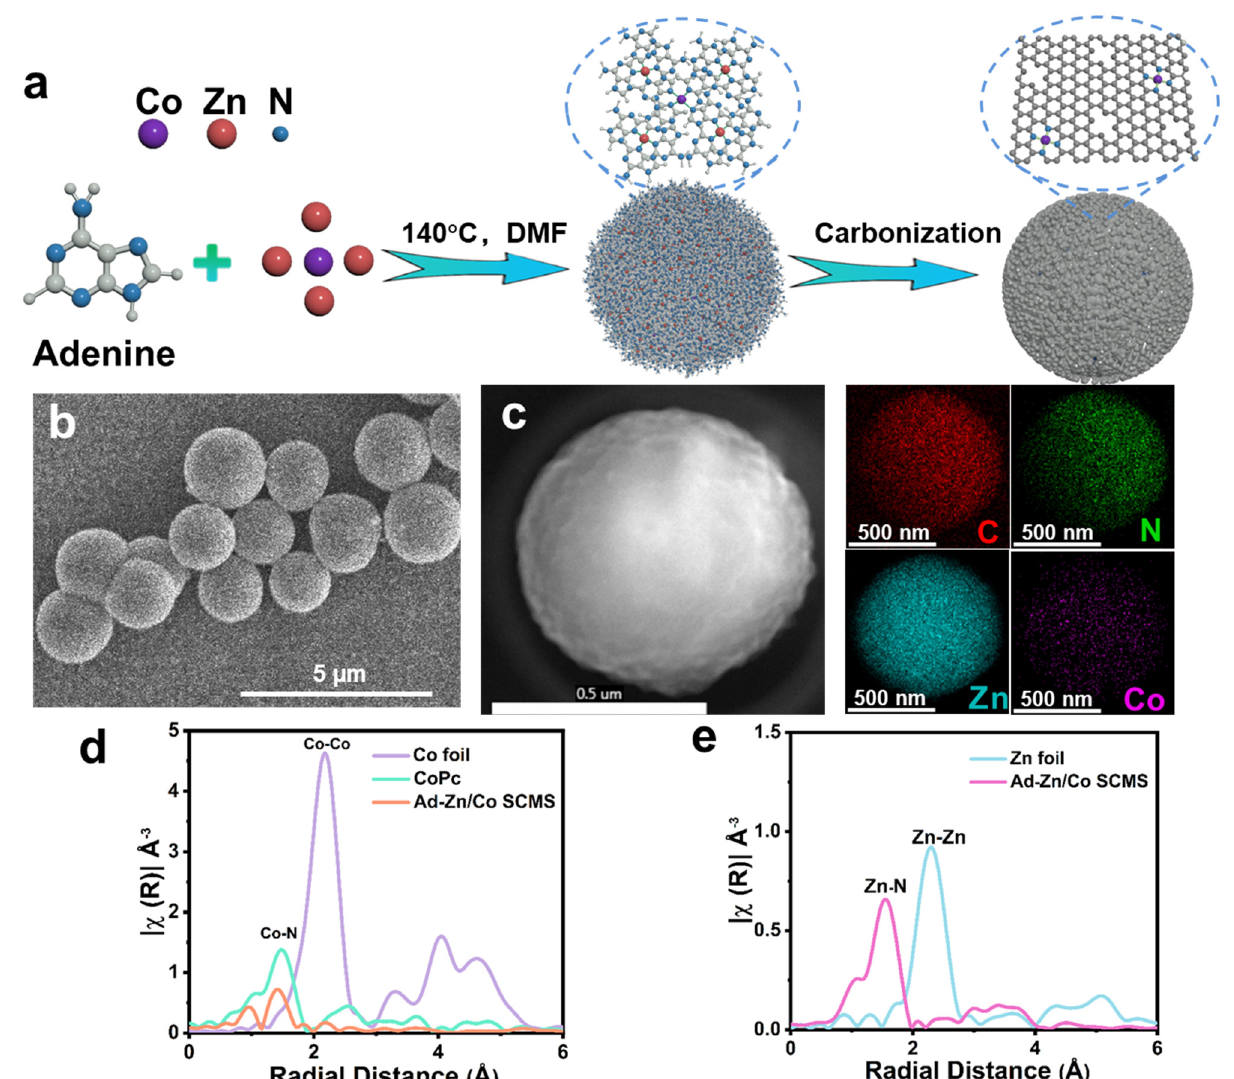
Figure 1. ( a ) Schematic diagram for synthesizing Ad − Zn/Co SCMS and CoSA/N − PCMS. ( b ) SEM image of Ad − Zn/Co SCMS. ( c ) Elemental mapping images of Ad − Zn/Co SCMS. ( d ) Co K-edge and ( e ) Zn K-edge FT-EXAFS spectra of Ad − Zn/Co SCMS and reference samples. Furthermore, XAS was used to characterize the chemical states and local structure of Co and Zn in Ad − Zn/Co SCMS. From the X − ray absorption near-edge structure (XANES) spectra (Figures S3a,b), the near-edge absorption energy of Co or Zn moves towards the high-energy region, indicating that Co or Zn exists in an oxidized state. More structural information about Co and Zn can be obtained from the extended X − ray absorption fi ne structure (EXAFS). The Co K-edge Fourier transform (FT) EXAFS spectrum (Figure 1d) of Ad − Zn/Co SCMS exhibits similar Co − N coordination with a peak located at ~1.41Å. Mean- while, the Zn K-edge FT-EXAFS spectrum (Figure 1e) of Ad − Zn/Co SCMS displays a main peak at ~1.56 Å, corresponding to the Zn − N sca tt ering path [40–43]. Therefore, both Co and Zn coordinate with N on adenine, con fi rming the feasibility of achieving Co atomic dispersion by precisely regulating the metal ratio. CoSA/N − PCMS exhibits regular microspheres with uniform distribution of C, N, and Co (Figures 2a and S4). Bene fi tt ing from the use of N-rich adenine as the ligand, the nitro- gen atom loading content in CoSA/N − PCMS was as high as 18.49 at% (Table S1). To fur- ther investigate the microstructure of the catalyst, high-resolution TEM (HRTEM) was used, and rough surface and edge defects on the CoSA/N − PCMS can be clearly seen in the